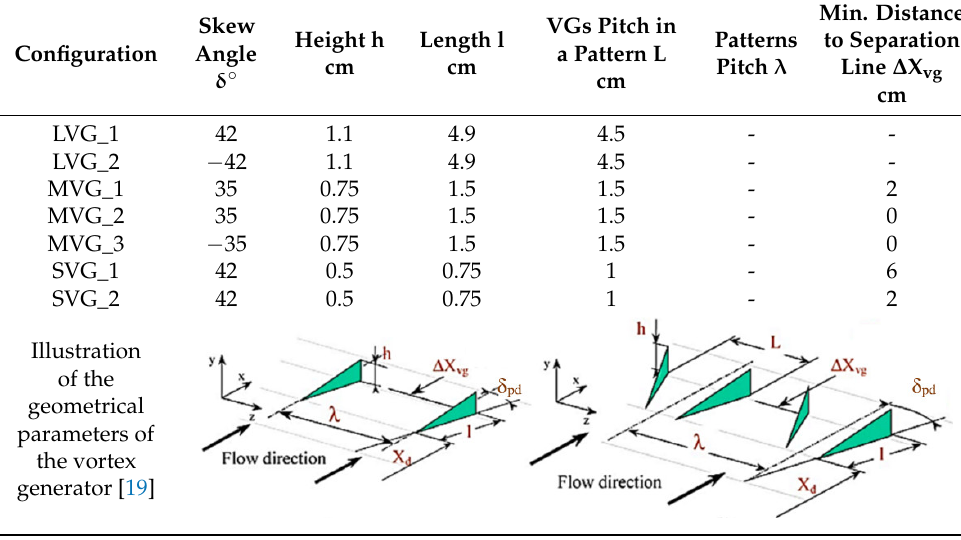
Table 1. Geometrical parameters of the tested configurations of vortex generators.